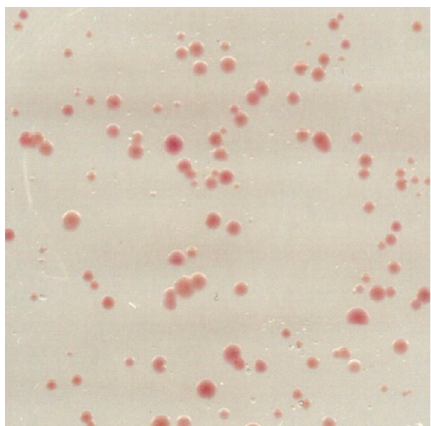
Figure 2. L37-agar plate of H. salinarum L33 transformed with BR-C-His 10 . A total of 50 µL of H. salinarum L33 cells transformed with BR-C-His 10 was plated out after 2 days of outgrowth in a dilution of 1:100 and incubated at 37 °C for two weeks. Shown is an excerpt of the plate 4 × 4 cm in size.